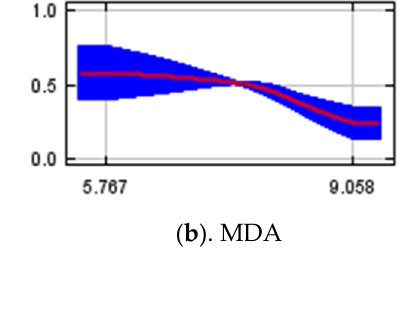
Figure 14. Factor response